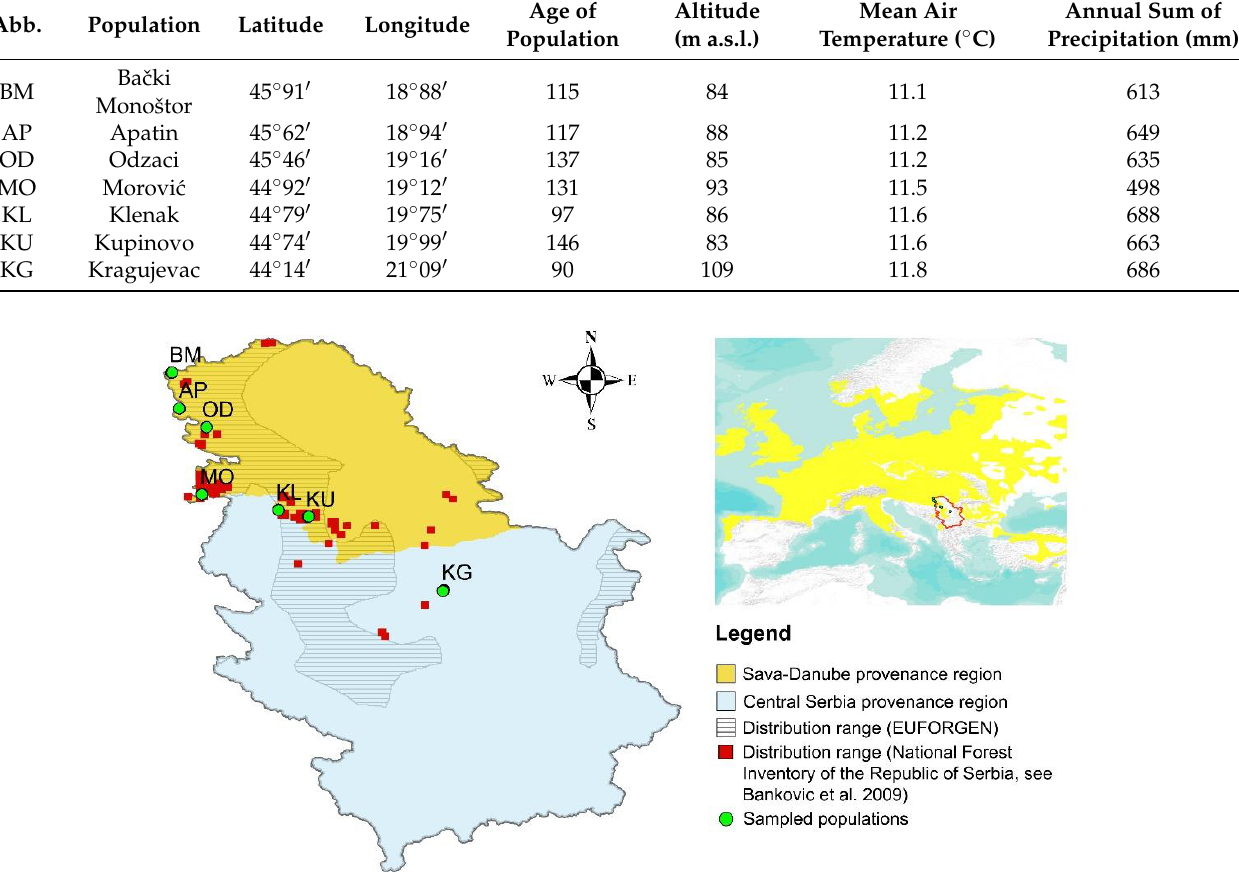
Figure 1. Geographical locations of pedunculate oak populations in the study.